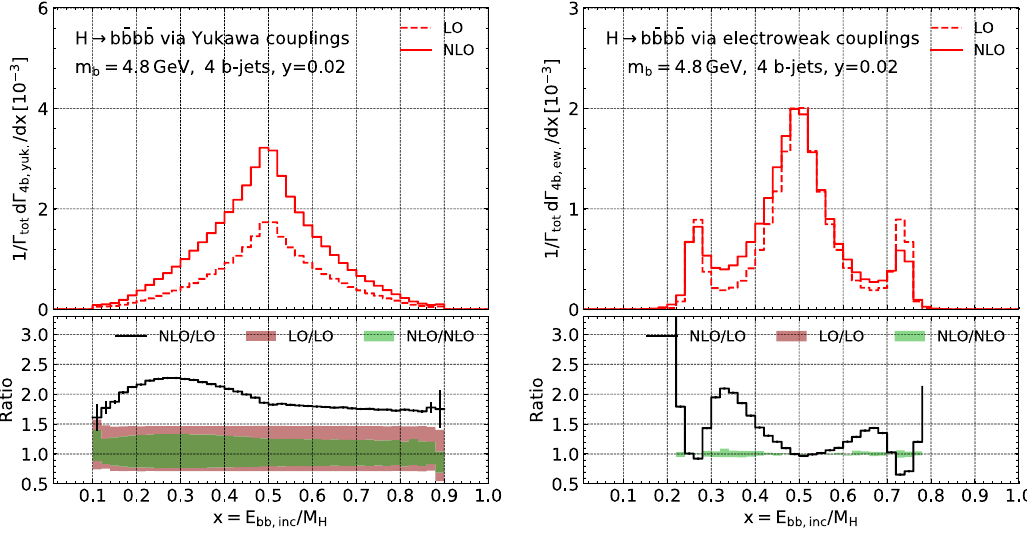
Figure 17 . Similar to figure 7 for distribution as a function of the inclusive energy of all b -jet